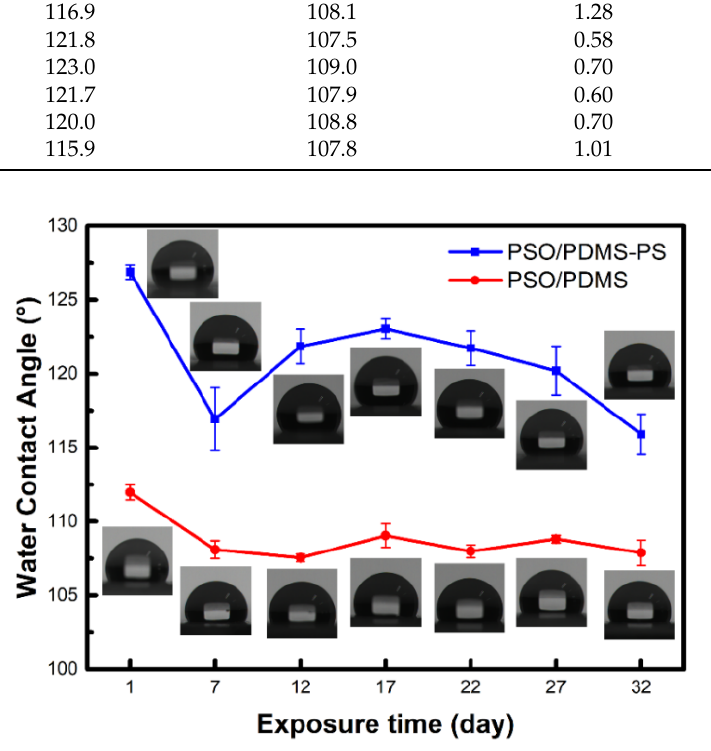
Figure 3. Change curve of water contact angle on sample surface with exposure time of PSO. Exposure conditions were under ambient conditions.